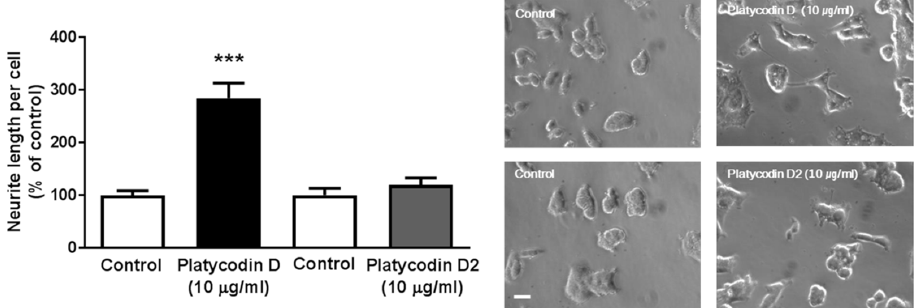
Figure 8. Measurement of neurite length to confirms the effects of bioactive molecules of PG in PC12 cells. PC12 cells were treated with 10 µg/mL platycodin D or platycodin D2 for 24 h and neurite lengths measured. Platycodin D, but not platycodin D2, treated PC12 cells show significantly increased neurite lengths. Scale bar = 20 µm. Values are the mean + SEM. *** p < 0.05 compared to the vehicle-treated control group.